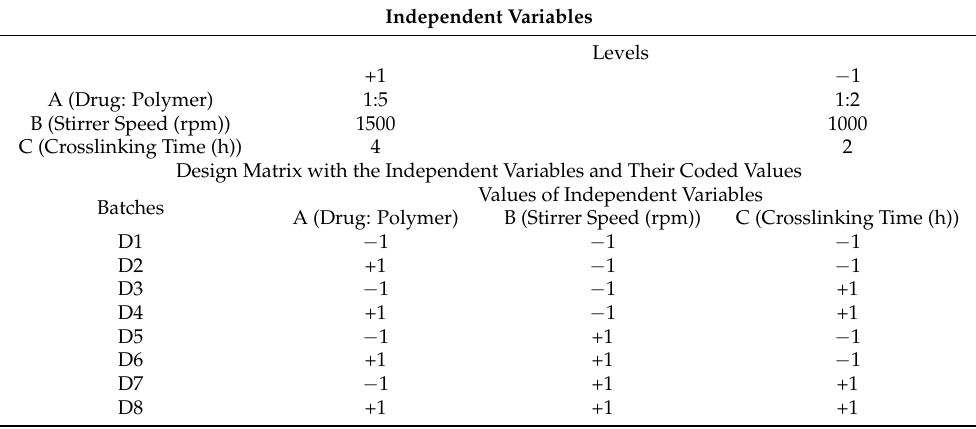
Table 1. Independent variables with levels and coded